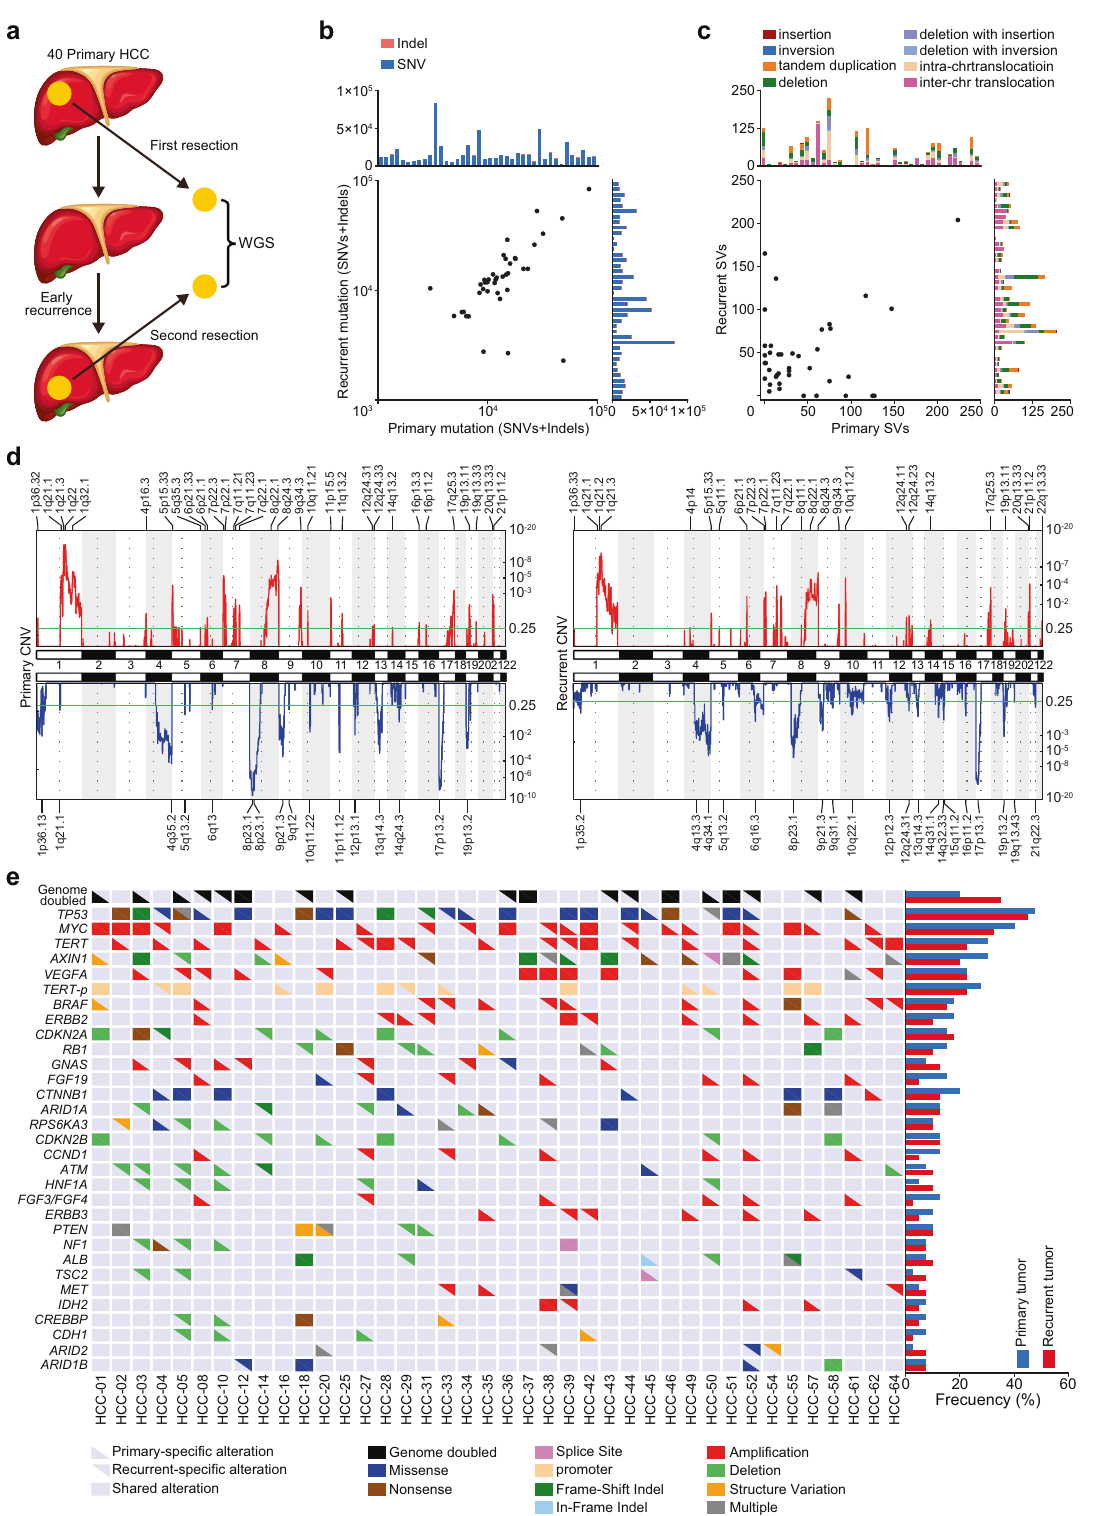
Fig. 1 Genomic landscape of 40 pairs of primary and early-recurrent HCCs. a A concise diagram of the sequencing research in the present HCC genomic study. b The number of somatic mutations (SNVs + indels) in the whole genome across 40 pairs of primary and early-recurrent HCCs. c The number of structural variations (SVs) in 40 pairs of primary and early-recurrent HCCs, including insertions, inversions, tandem duplications, deletions, and inter- and intra-chromosomal translocations. d GISTIC analysis revealed the whole-genome distribution of copy-number alterations in paired primary (left panel) and early-recurrent (right panel) HCCs. GISTIC q -values ( y -axis) for ampli fi cations (upper, red) and deletions (lower, blue) are plotted across the genome ( x -axis). e The genomic alteration of driver genes in 40 pairs of primary and early-recurrent HCCs, identi fi ed through whole-genome sequencing. Drivers present in ≥ 4 patients are shown. All mutations (SNVs + indels) were validated by Sanger sequencing